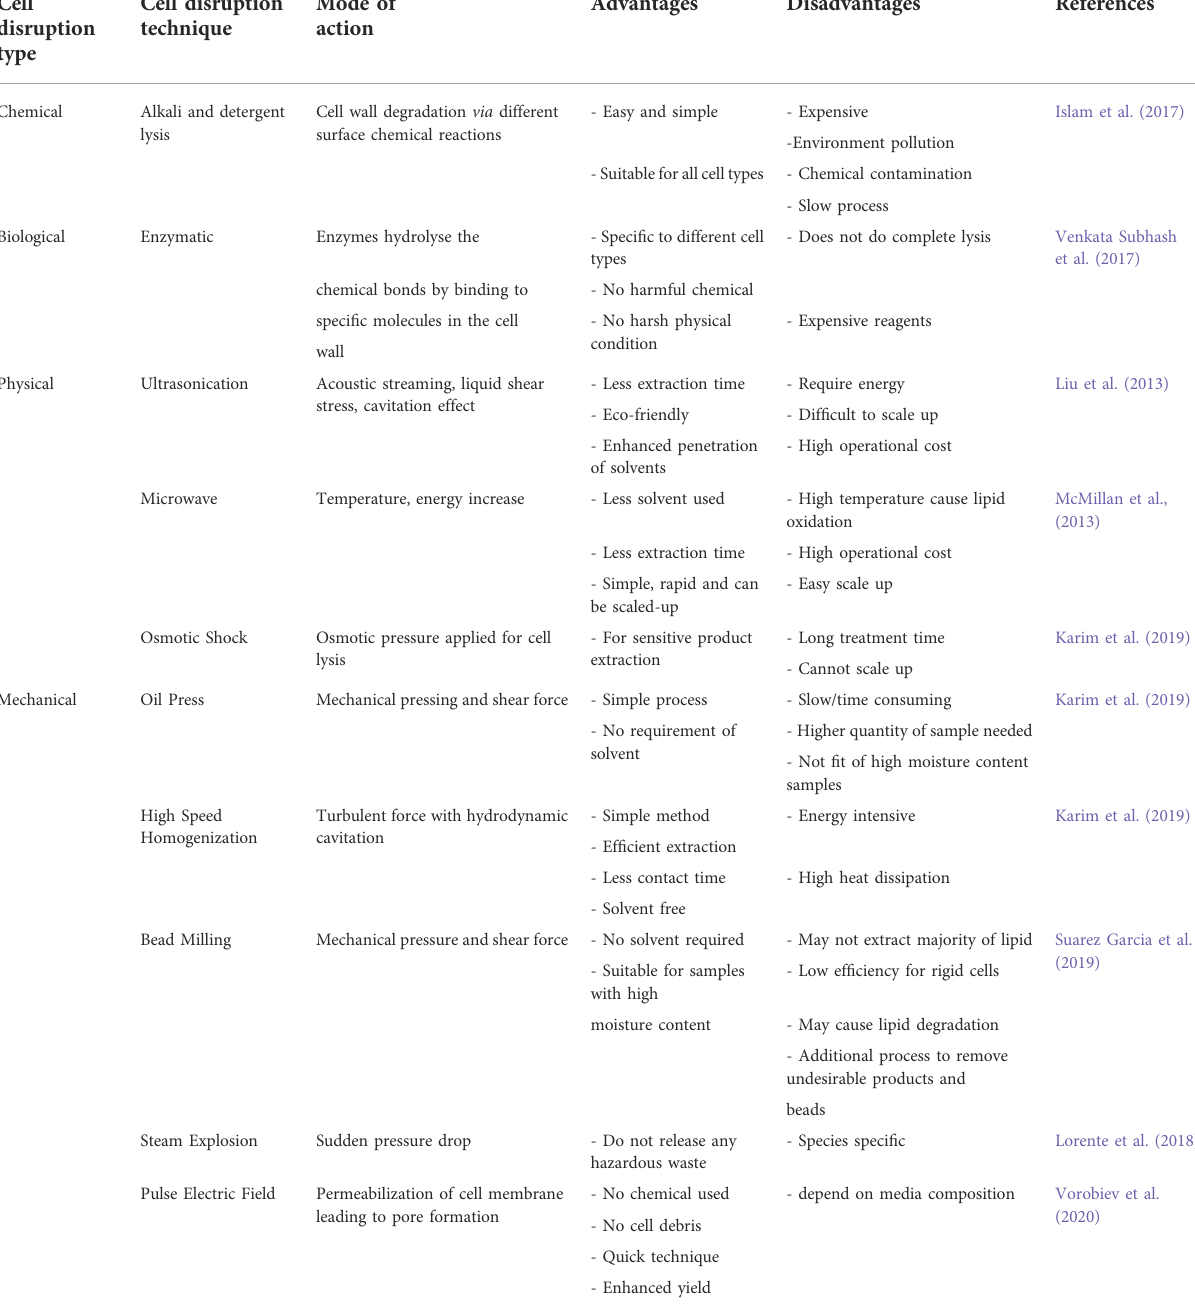
TABLE 1 Advantages and disadvantages of different cell disruption